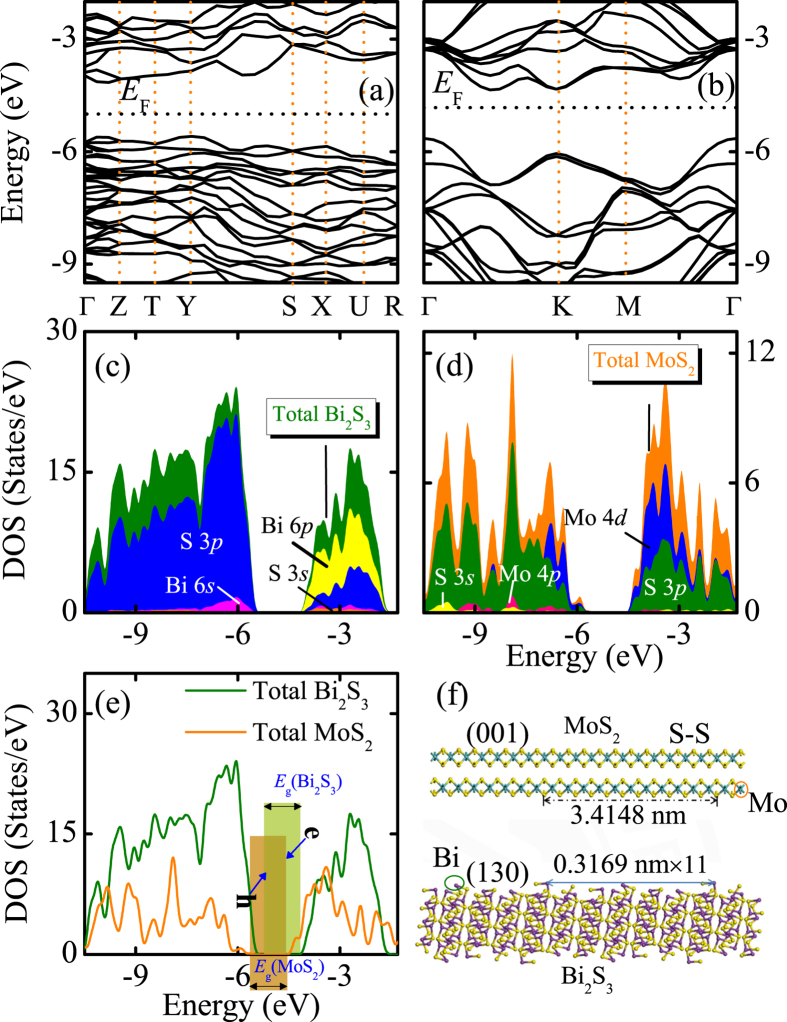
Calculated band structures (a,b), the density of states (c–e), and the crystal surface matching between the (130) and (001) crystal surfaces (f) of Bi2S3 and MoS2, respectively.